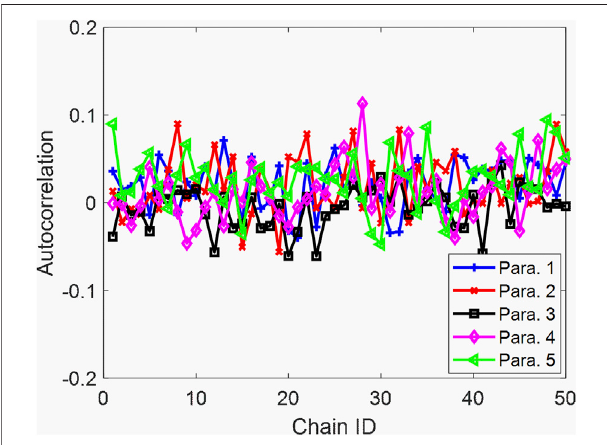
FIGURE 15 | Last-lag autocorrelation values of all Markov chains (case